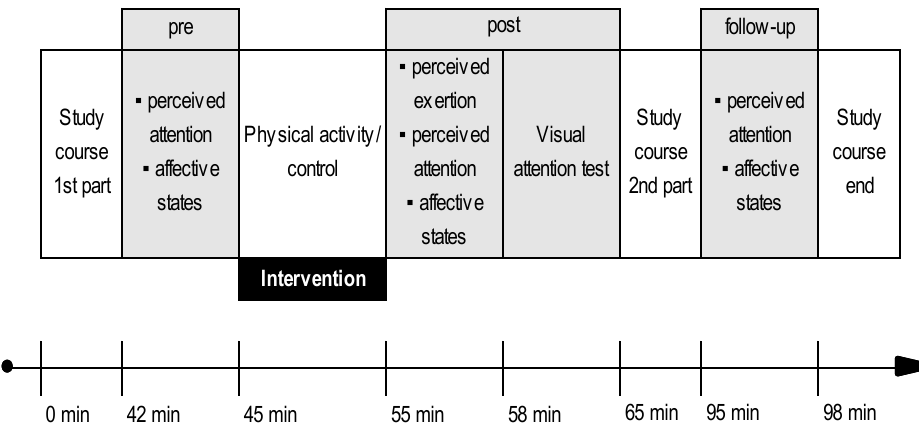
Figure 2. Experimental procedure. Grey fields mark data collection time points.